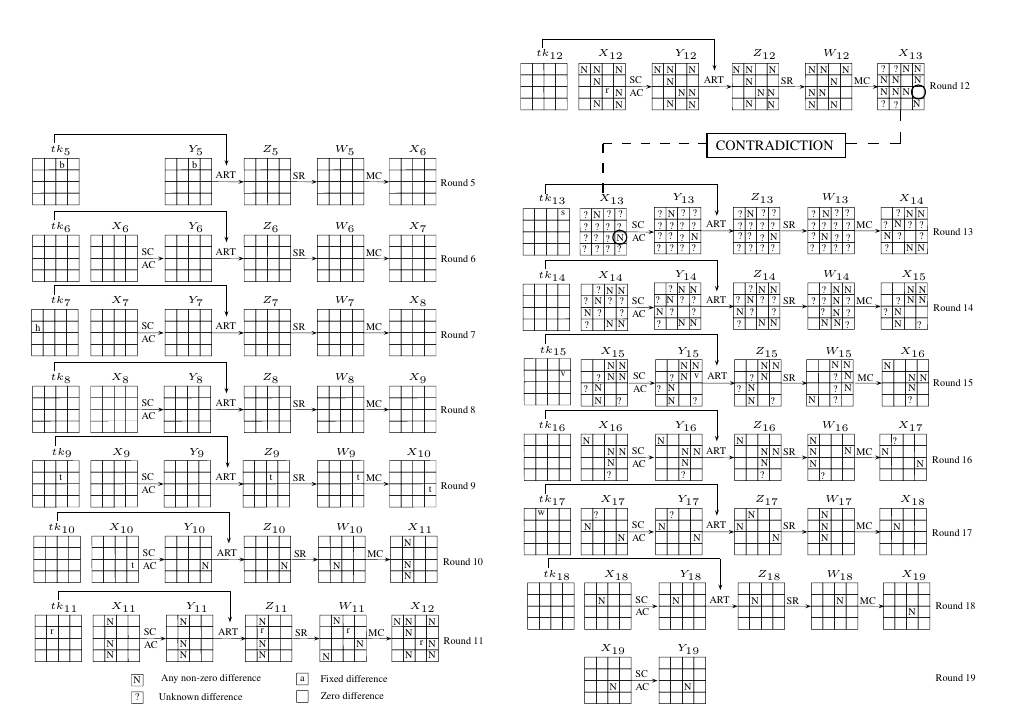
Figure 5: 14-round related-tweakey impossible distinguisher on SKINNY- n -2 n . E 0 under a pair of related-tweakeys and is used to attack E = E f ◦ E 0 ◦ E b . Through E − 1 ( E f ), ∆ X (∆ Y ) is propagated to ∆ in (∆ out ) with probability 1. Let c in ( c out ) be the number of bit conditions that need to be verified for ∆ in → ∆ X (∆ Y ← ∆ out ), and k in ( k out ) is the key information involved in E b ( E f